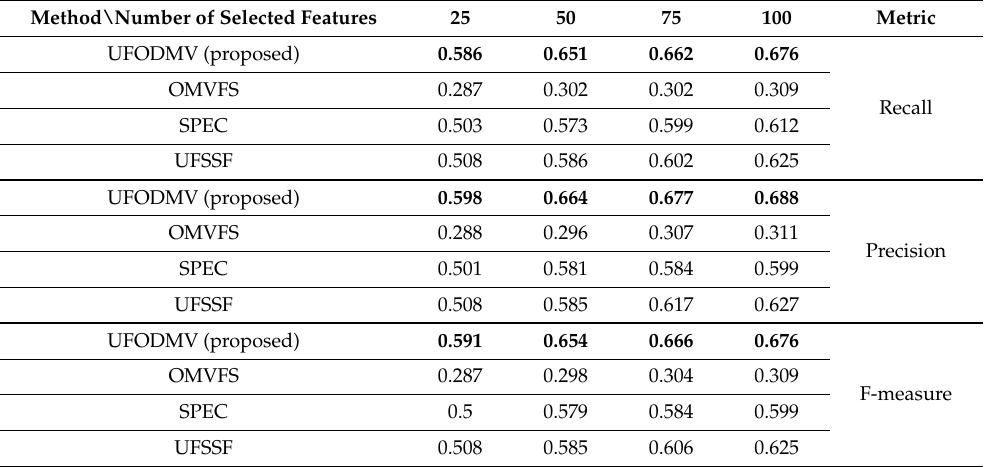
Table 8. Classification accuracy using Fox News dataset with